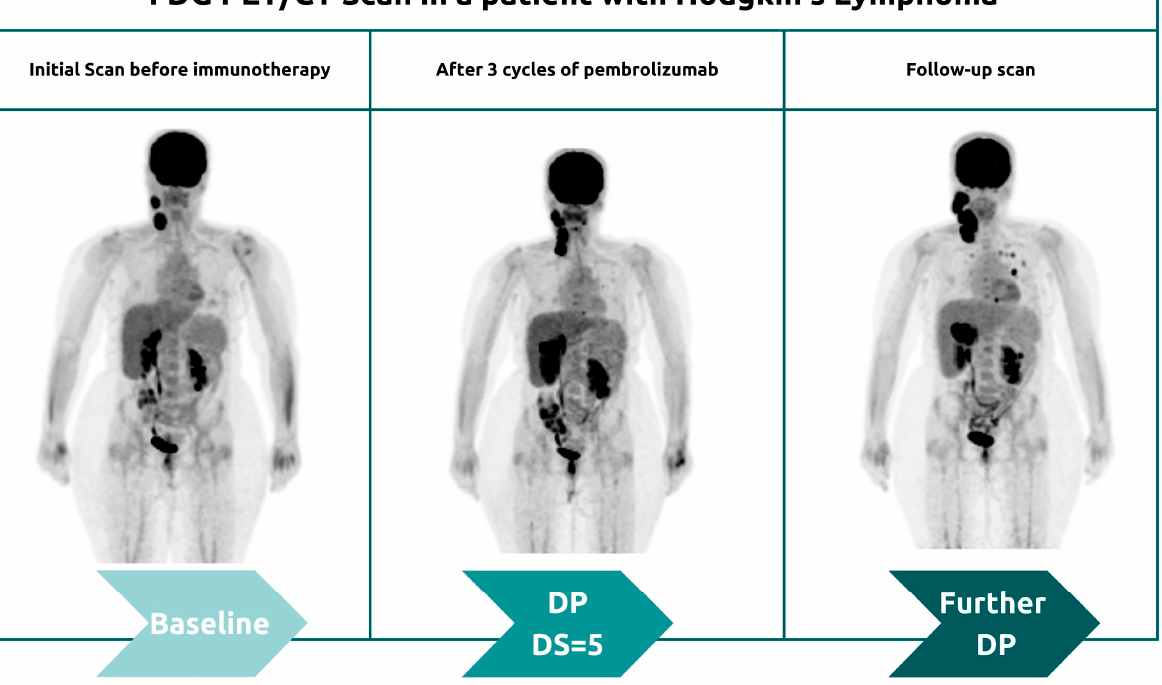
Figure 6. Serial Maximum Intensity Projection (MIP) images of an HL patient demonstrating a hyperprogression pattern.